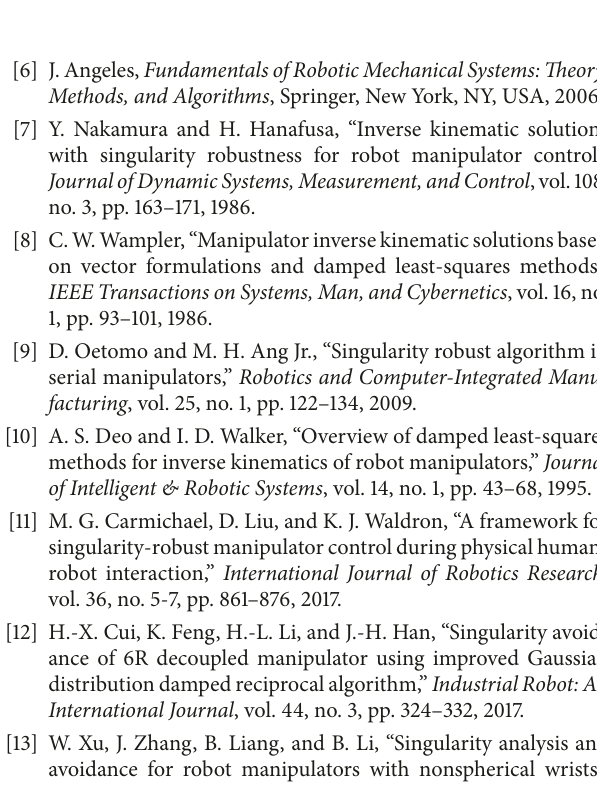
Figure 11: The tracking errors